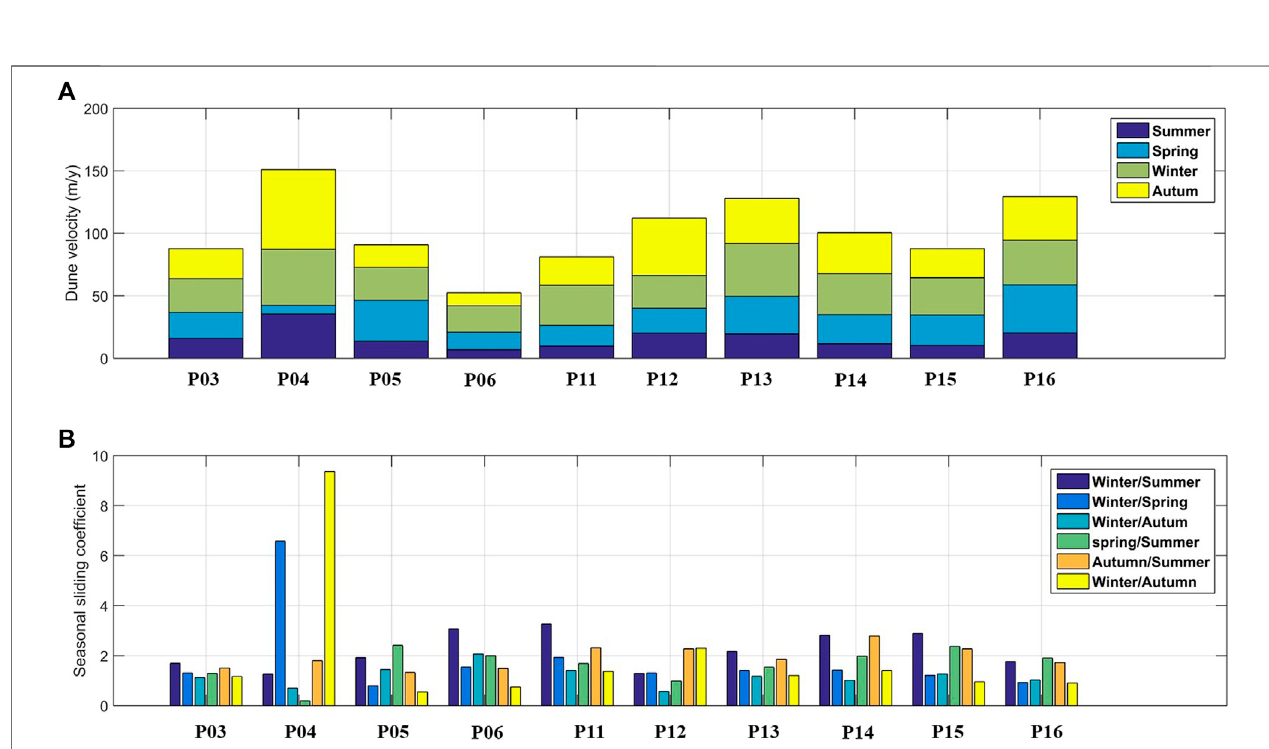
FIGURE 11 | Median seasonal velocity at different points belong to Landsat-8 frame 183/48 (A) . The seasonal sliding coef fi cients denote the ratio between the different seasonal velocities (B) .